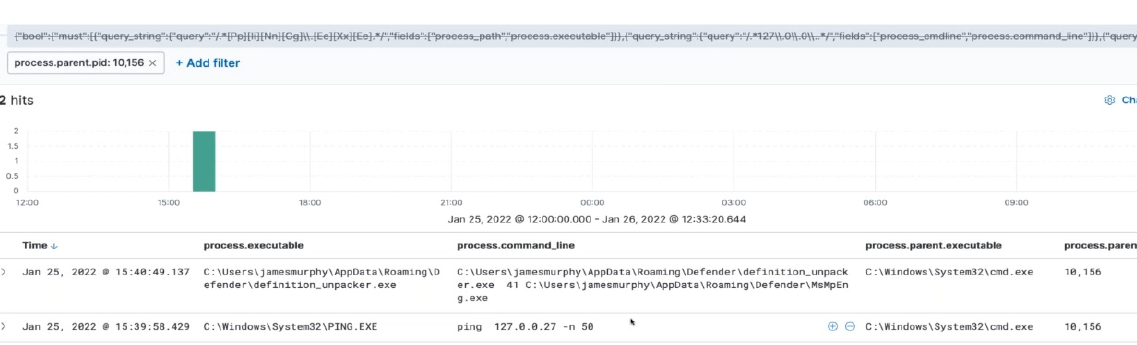
Figure 13. Filtering results.